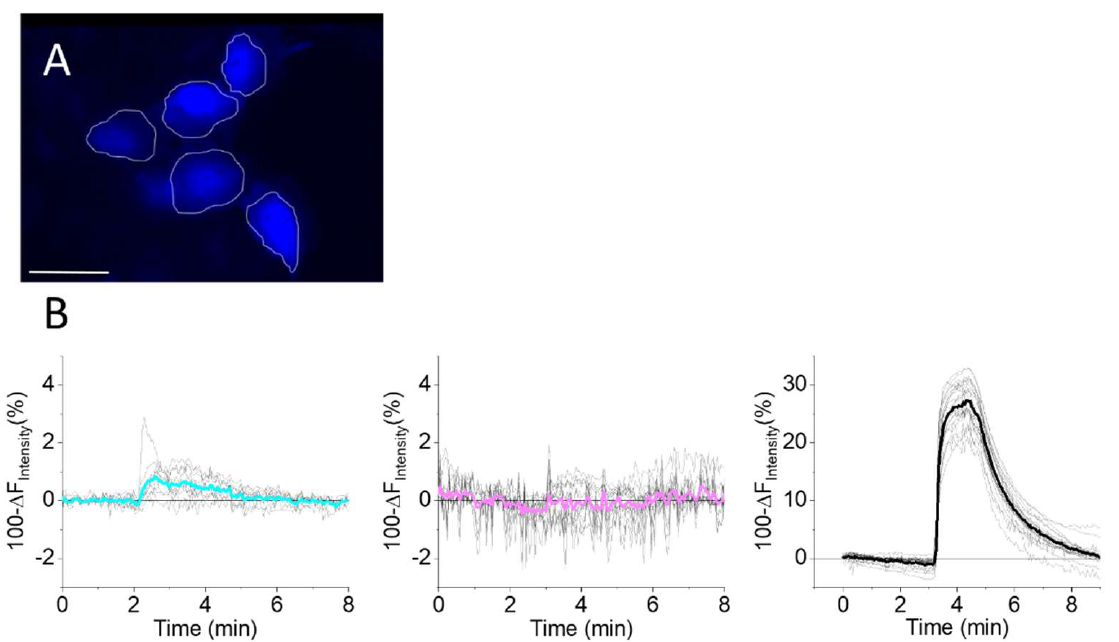
Figure 6. ( A ) HeLa cells expressing mTagBFP2. Scale bar represents 20 µ m. ( B ) Fluorescence intensity over time of HeLa cells expressing mTagBFP2 (left), mTagBFP2 C26A C114S C222S (middle), and C-geNOp (right) in response to 3 mM SNP perfused at around 2.5 min, causing NO release. Note that the sign of fluorescence change is inverted due to plotting 100 - ∆ F Intensity